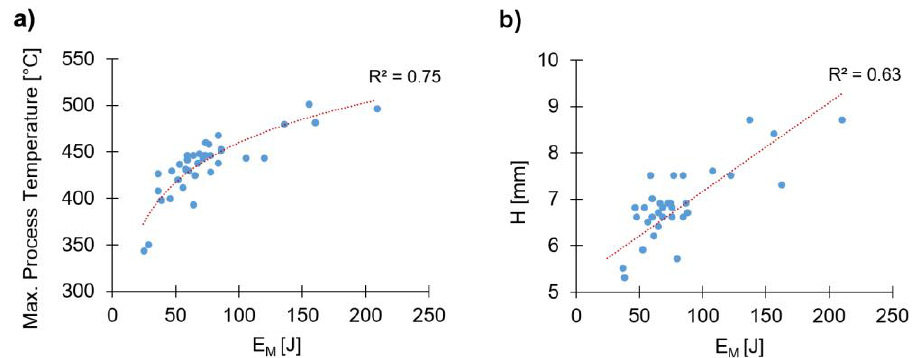
Figure 11. Total energy input, E M , correlations with: ( a ) maximum process temperature; and ( b ) rivet penetration depth, H.